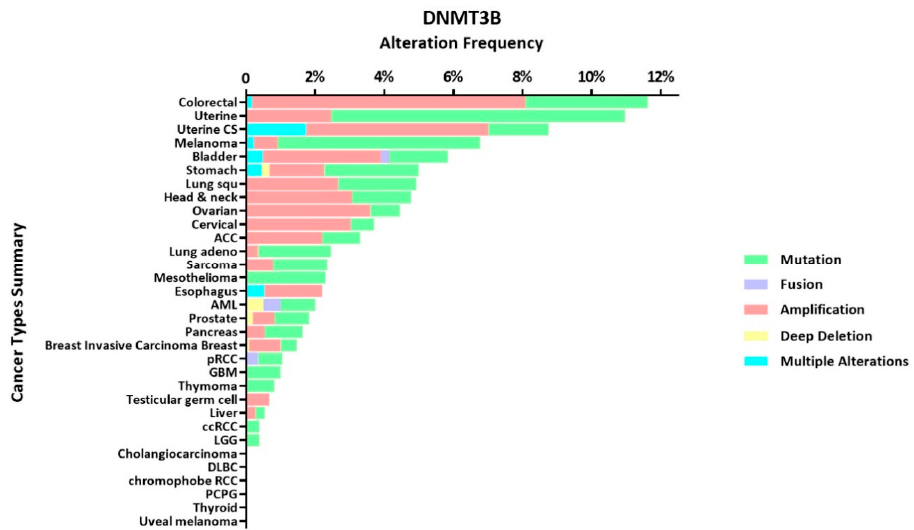
Figure 3. DNMT alteration frequency in cancer types summary. DNMT1, DNMT3A, DNMT3B occur mutation, fusion, amplification, deep deletion and multiple alterations in variety cancer types from cBioPortal datasets.